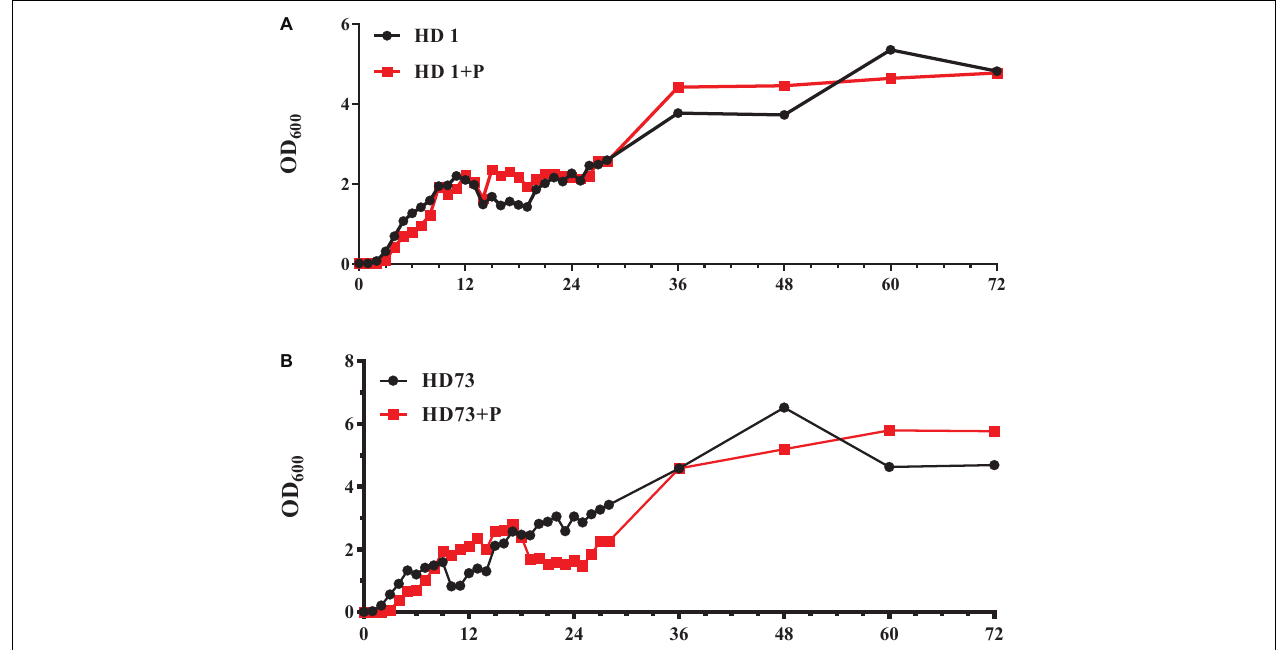
FIGURE 5 | Growth curves of free-living Bt cells with or without the induction of pectin. (A) Bt HD1. (B) Bt HD73.